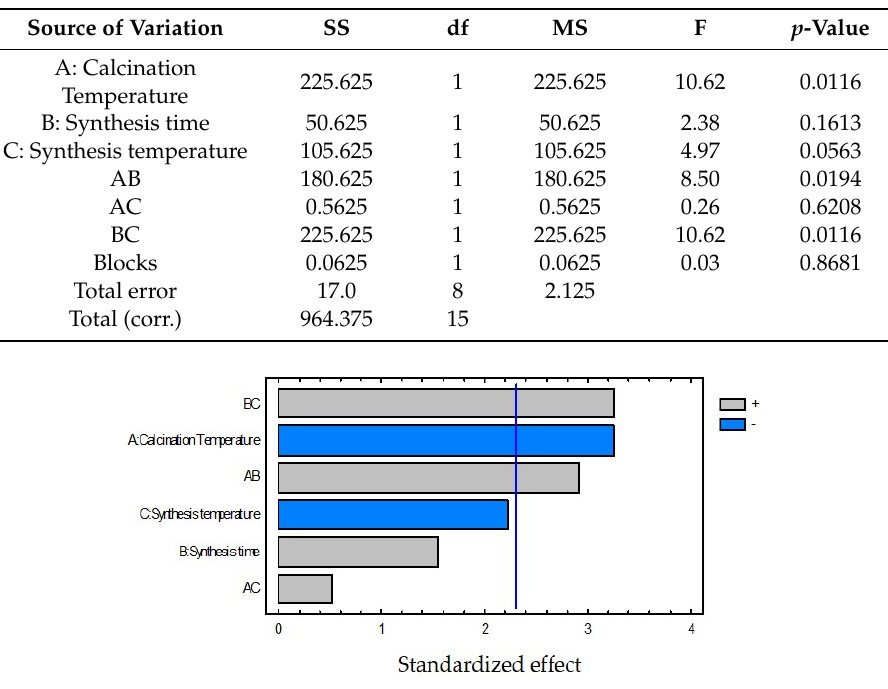
Table 3. ANOVA for degradation percentage of K 3 [Fe(CN) 6 ].